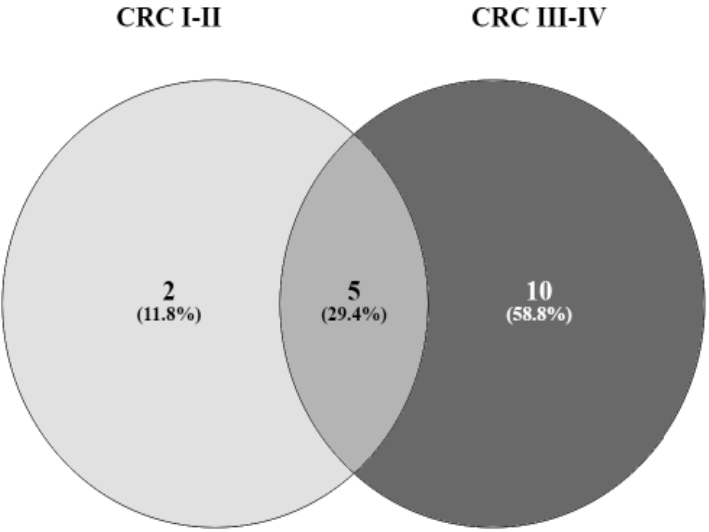
Figure 2. Venn diagram showing the number of shared and unique pathways that include targeted VFs detected at different stages of